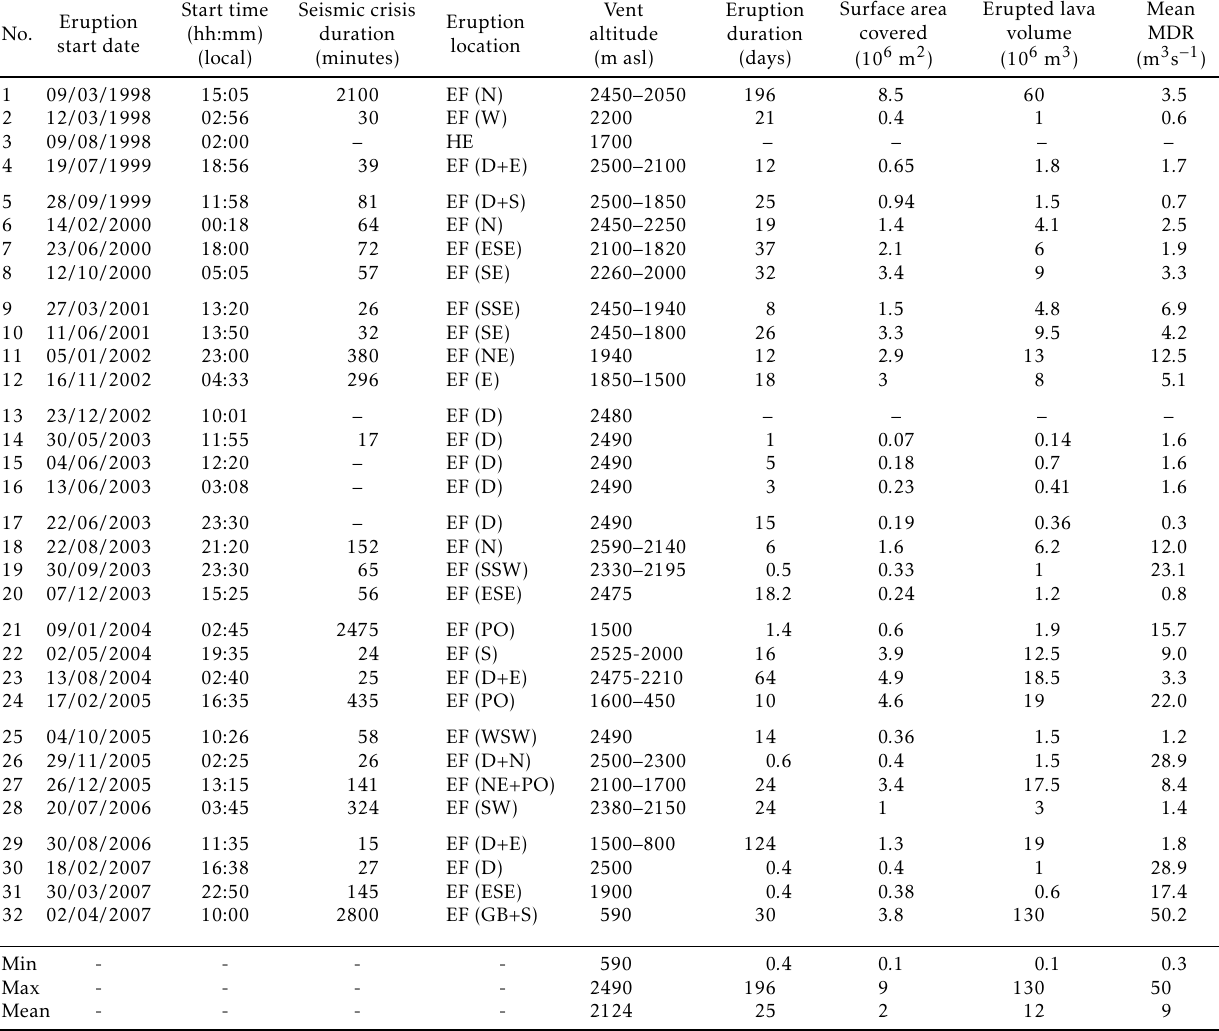
Table 1: Summary table of eruptive activity at Piton de la Fournaise for the period 1998–2007 [modified from Staudacher et al. 2008]. Seismic crisis is the period between the first seismic signal and the beginning of the eruptive activity. For eruption location, acronyms are as follows: EF = Enclos Fouqué, HE = Hors Enclos, D = Dolomieu, PO = Plaine des Osmondes (see Figure 1A), GB = Grand Brûlé (see Figure 1A). Surface area covered is related to lava flows. MDR = mass discharge rate, obtained by dividing the total volume and the eruption duration.